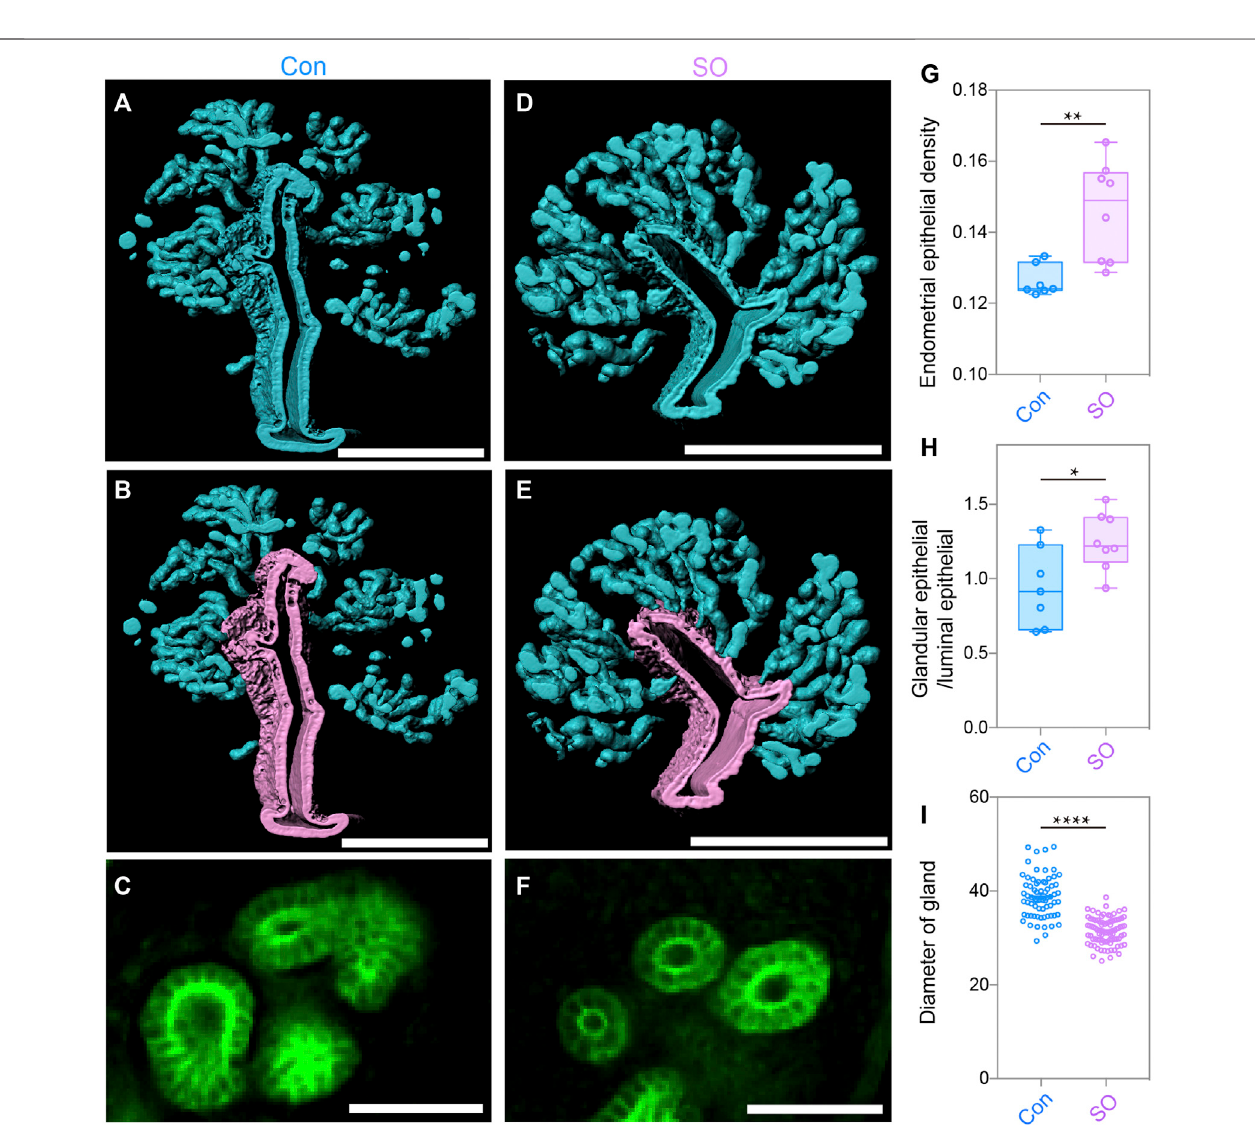
FIGURE 2 | Uterine epithelial changes in the 3D level after superovulation. (A) 3D rendering of uterine epithelium of the control group. (B) 3D rendering of glandular epithelium(blue)andluminalepithelium(purple)ofthecontrolgroup. (C) Light-sectionoftheuterineglandinthecontrolgroup. (D) 3D-renderingoftheuterineepithelium of the superovulation group. (E) 3D rendering of the glandular epithelium (blue) and the luminal epithelium (purple) of the superovulation group. (F) Light-section of the uterine gland in the superovulation group. (G) Comparing endometrial epithelial density in the control and superovulation groups. (H) Comparing the ratio of glandular epithelium/total epithelium in the control and superovulation groups. (I) Comparing the glandular diameter in the control and superovulation groups. Scale bar of (A,B,D,E) = 350 μ m. Scale bar of (C,F) = 50 μ m. The results are shown as means ± SEM. * p < 0.05, ** p < 0.01, *** p < 0.001, **** p < 0.0001. n ≥ 7.